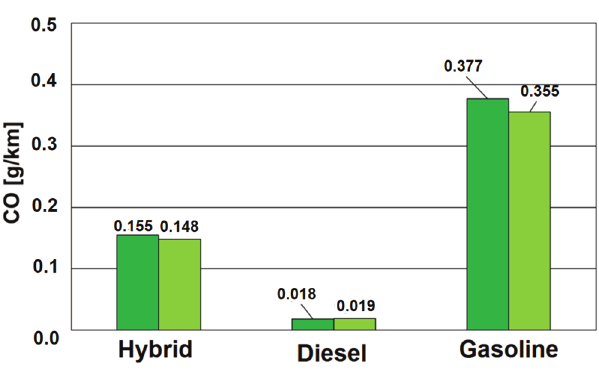
Fig. 14. CO road emission for each of the vehicles in the whole RDE test (EMROAD and all data)